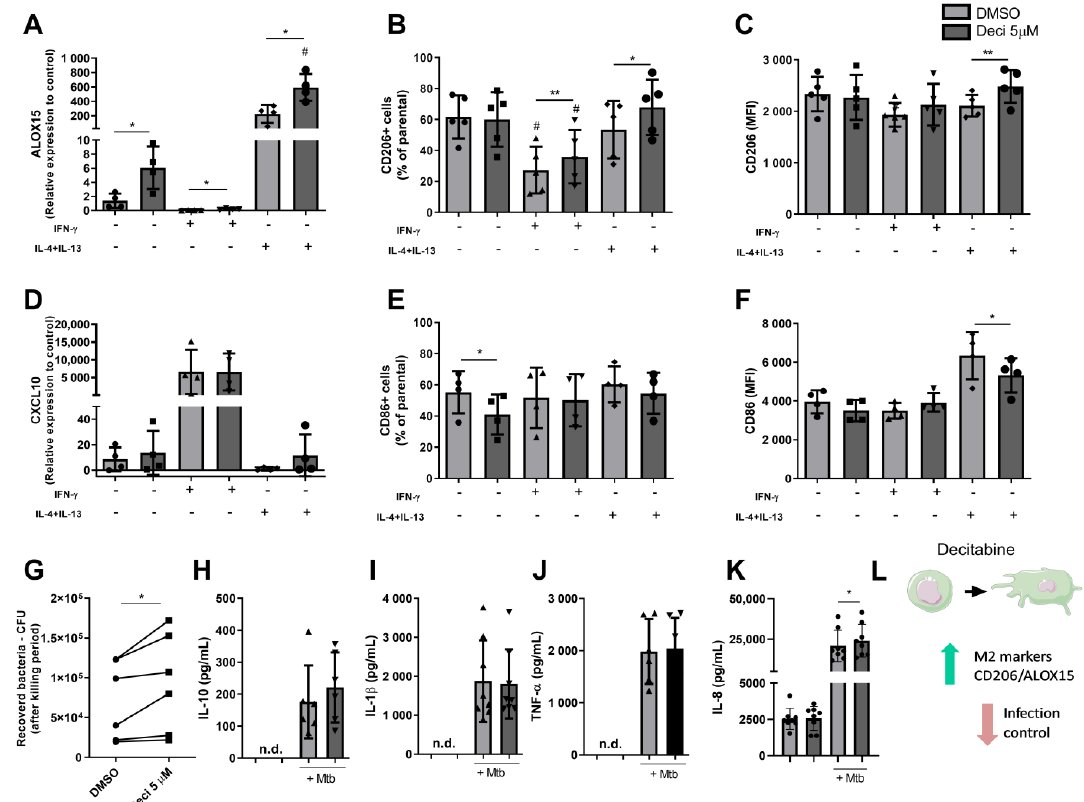
Figure 2. Decitabine modulated macrophage function by potentializing the M2 like profile. Monocytes from healthy subjects were isolated from peripheral blood and cultured for 6 days in the RPMI 1640 medium supplemented with 10% FBS and 50 ng/mL granulocyte-macrophage colony-stimulating factor (GM-CSF), and 5 μM decitabine or DMSO (0.2%) added for macrophage differentiation. On the 6th day, differentiated macrophages were stimulated with cytokines for macrophage polarization or infected with Mtb for functional analysis. The M1 profile was defined by the addition of IFN-γ (100 ng/mL) and M2, by IL-4 and IL-13 (50 ng/mL each). After 24 h in the presence of polarizing cytokines, the macrophage profile was determined by gene expression of ALOX15 ( A ) and CXCL10 ( D ). The expression was normalized using Ct of the endogenous gene ( ACTB ) and the relative expression calculated using 2 −ΔΔCt in relation to resting macrophages differentiated with DMSO. In addition, surface markers CD206 (( B ) frequency, and ( C ) Mean Fluorescence Intensity) and CD86 (( E ), frequency and ( F ), Mean Fluorescent Intensity—MFI) ( D , F ) were analyzed by flow cytometry. For functional analysis, after the differentiation period in the presence of decitabine or DMSO, macrophages were infected with Mtb and 24 h post-infection, cells were lysed to bacterial load determination through colony forming units (CFU) count, represented